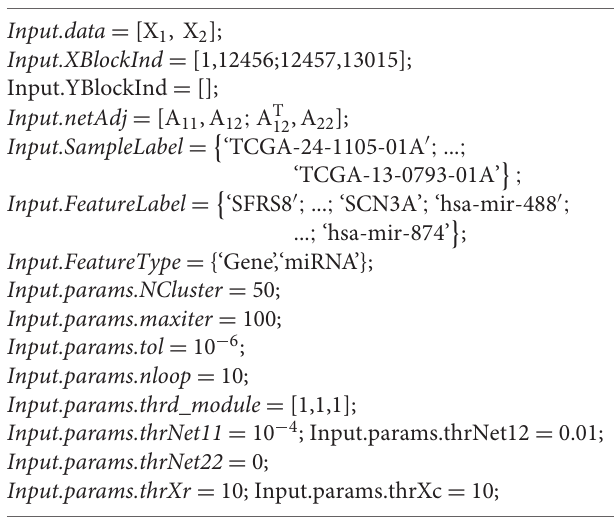
( Figure 2B ), sample-wise correlations between input data and reconstructed data ( Figure 2C ) and size distributions for multi-type module members ( Figure 2D